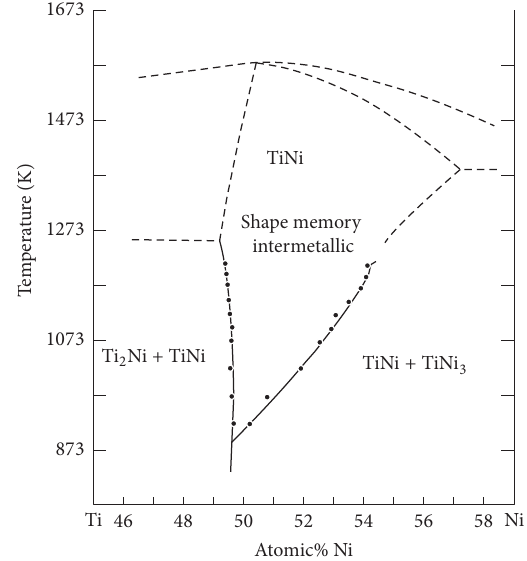
Figure 3: Partial phase diagram of NiTi from 45% nickel to 59% nickel. Details of this figure are given in